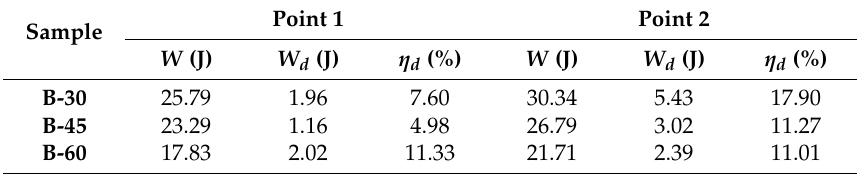
Table 2. The corresponding total work and dissipated energy of the stress drop points (units: J; %).